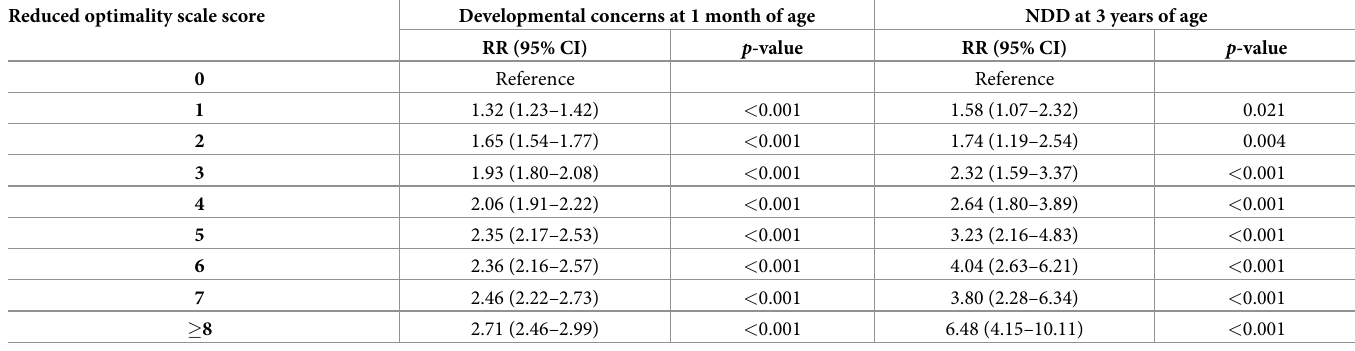
Table 5. Relative risks of developmental concerns at 1 month of age and of a diagnosis of neurodevelopmental disorder at 3 years of age for each suboptimality scale score. Reduced optimality scale